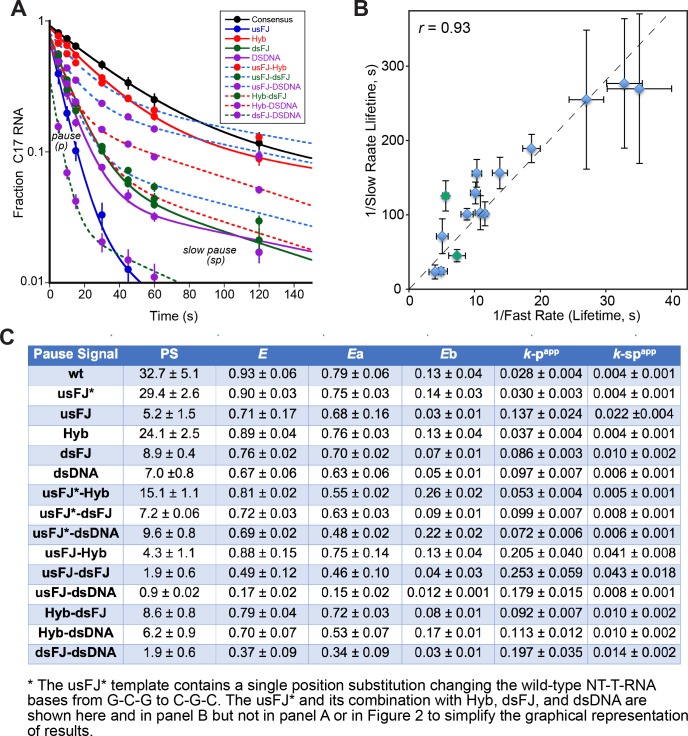
(A) Quantitation of pause assays with scaffold variants described in Figure 2.All pause assays were performed with the same RNAP preparation. (B) Plot of fast species lifetime (1/k-p, app) vs. slow species life (1/k-sp, app) for each scaffold variant. The high positive correlation between the two species rates is consistent with a model in which a single kinetic barrier limits escape from either pause species. (C) Summary table of pause strength (PS), efficiency (E), fast species fraction (Ea), slow species fraction (Eb), fast species rate (k-p, app), and slow species rate (k-sp, app).